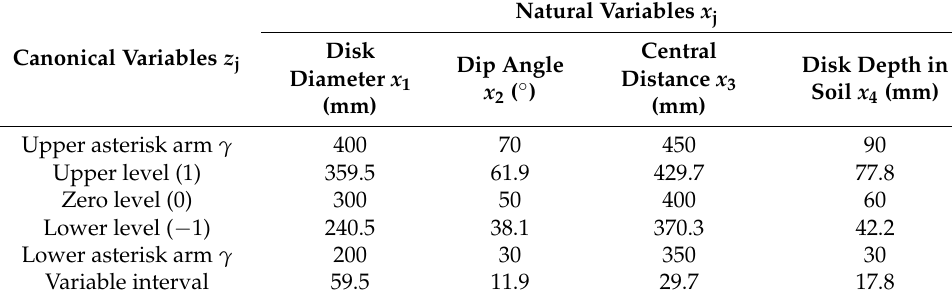
Table 3. Test factor coding.